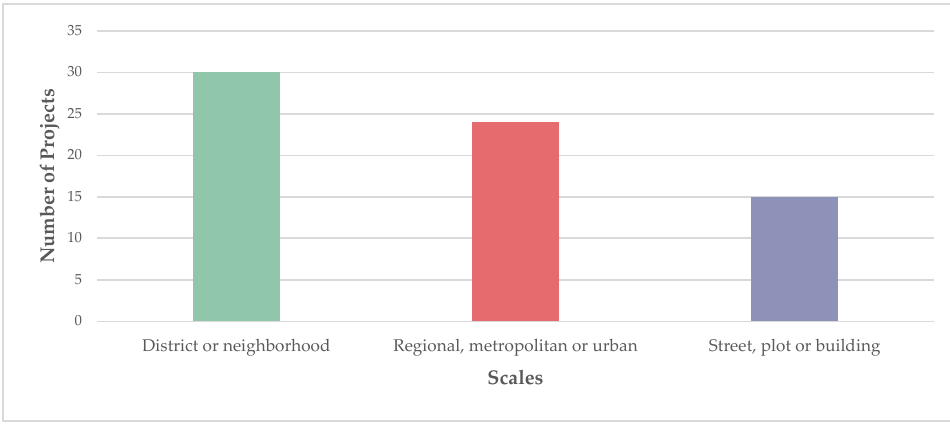
Figure 5. Spatial scale NbS of implementation.